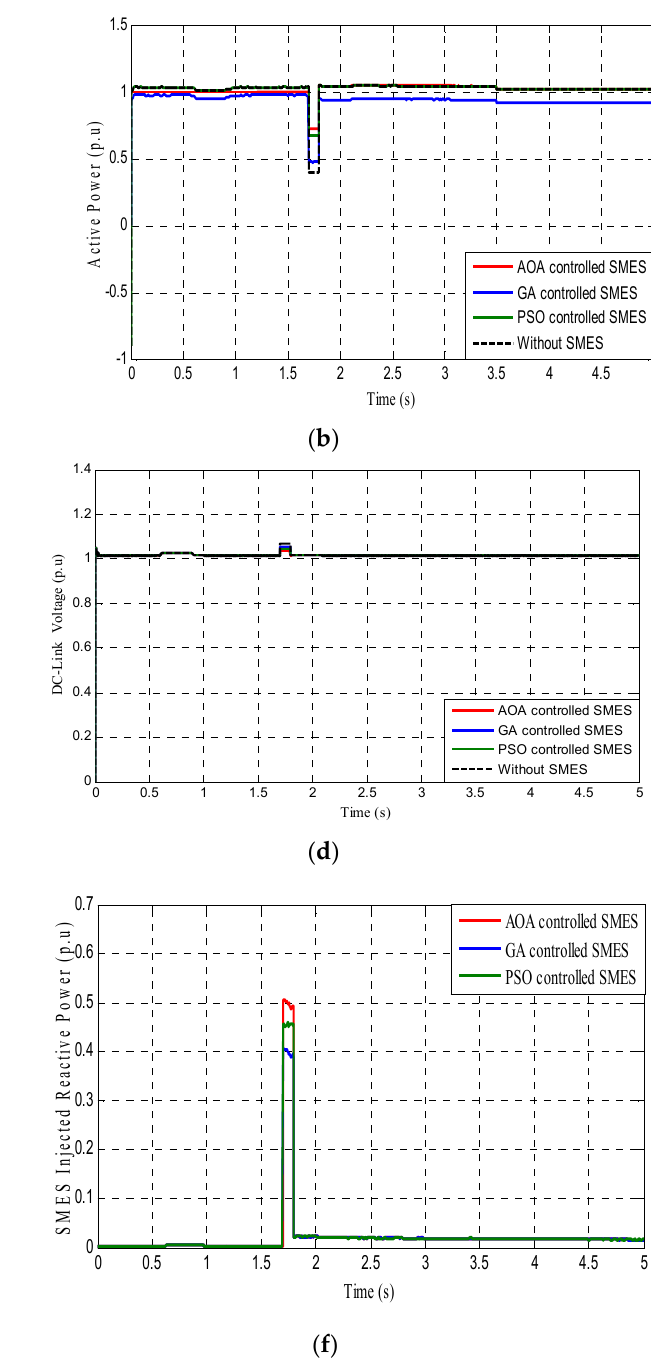
Figure 14. Simulation curves for L ‐ G fault using the AOA, the GA, and PSO: ( a ) terminal voltage; ( b ) P curve; ( c ) Q curve; ( d ) DC link voltage curve; ( e ) SMES ‐ injected active power; ( f ) SMES ‐ injected reactive power.